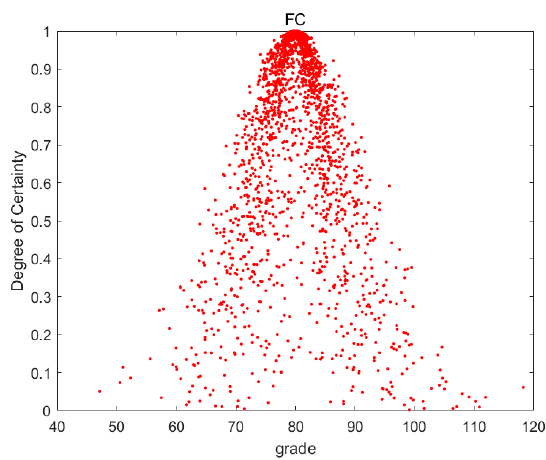
Figure 3. Cloud image of FC.